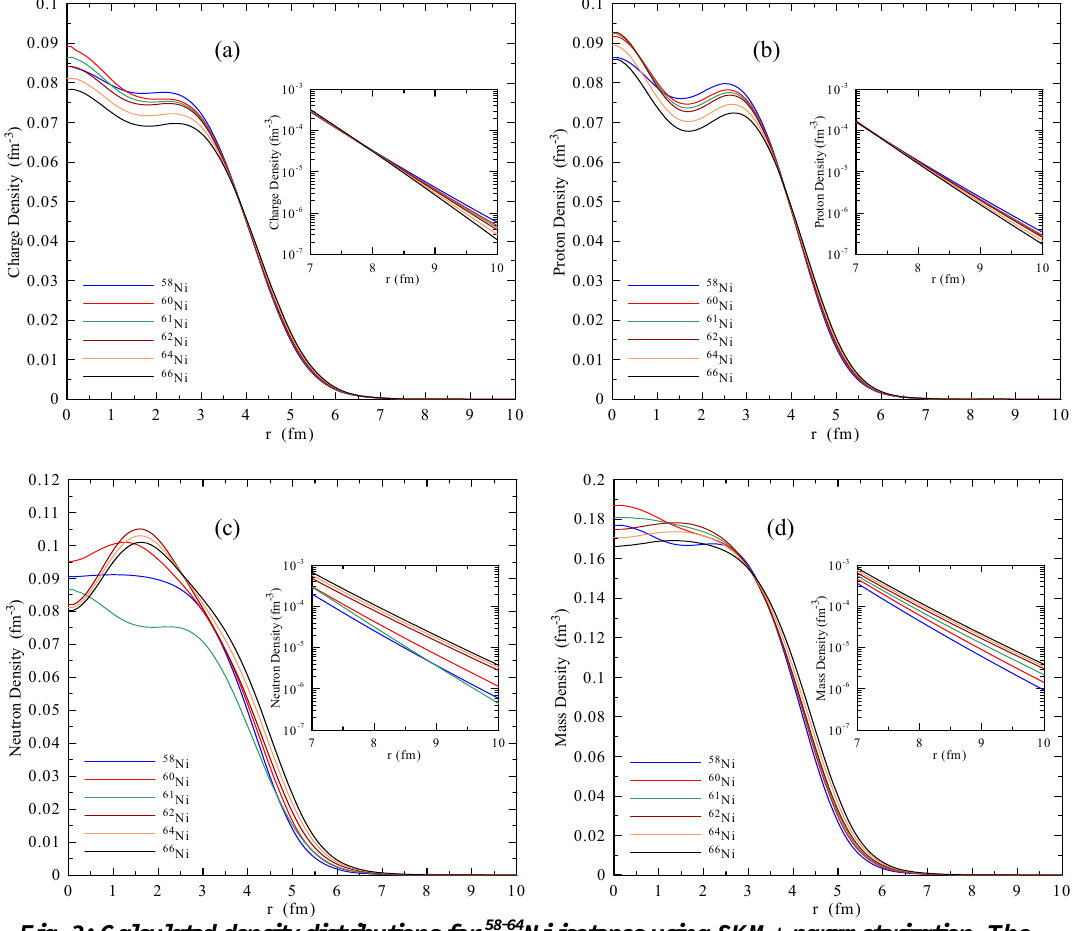
Fig. 3: Calculated density distributions for 58-64 Ni isotopes using SKM* parameterization. The inset is in logarithmic scale. (a) charge density, (b) proton density, (c) neutron density and (c) mass